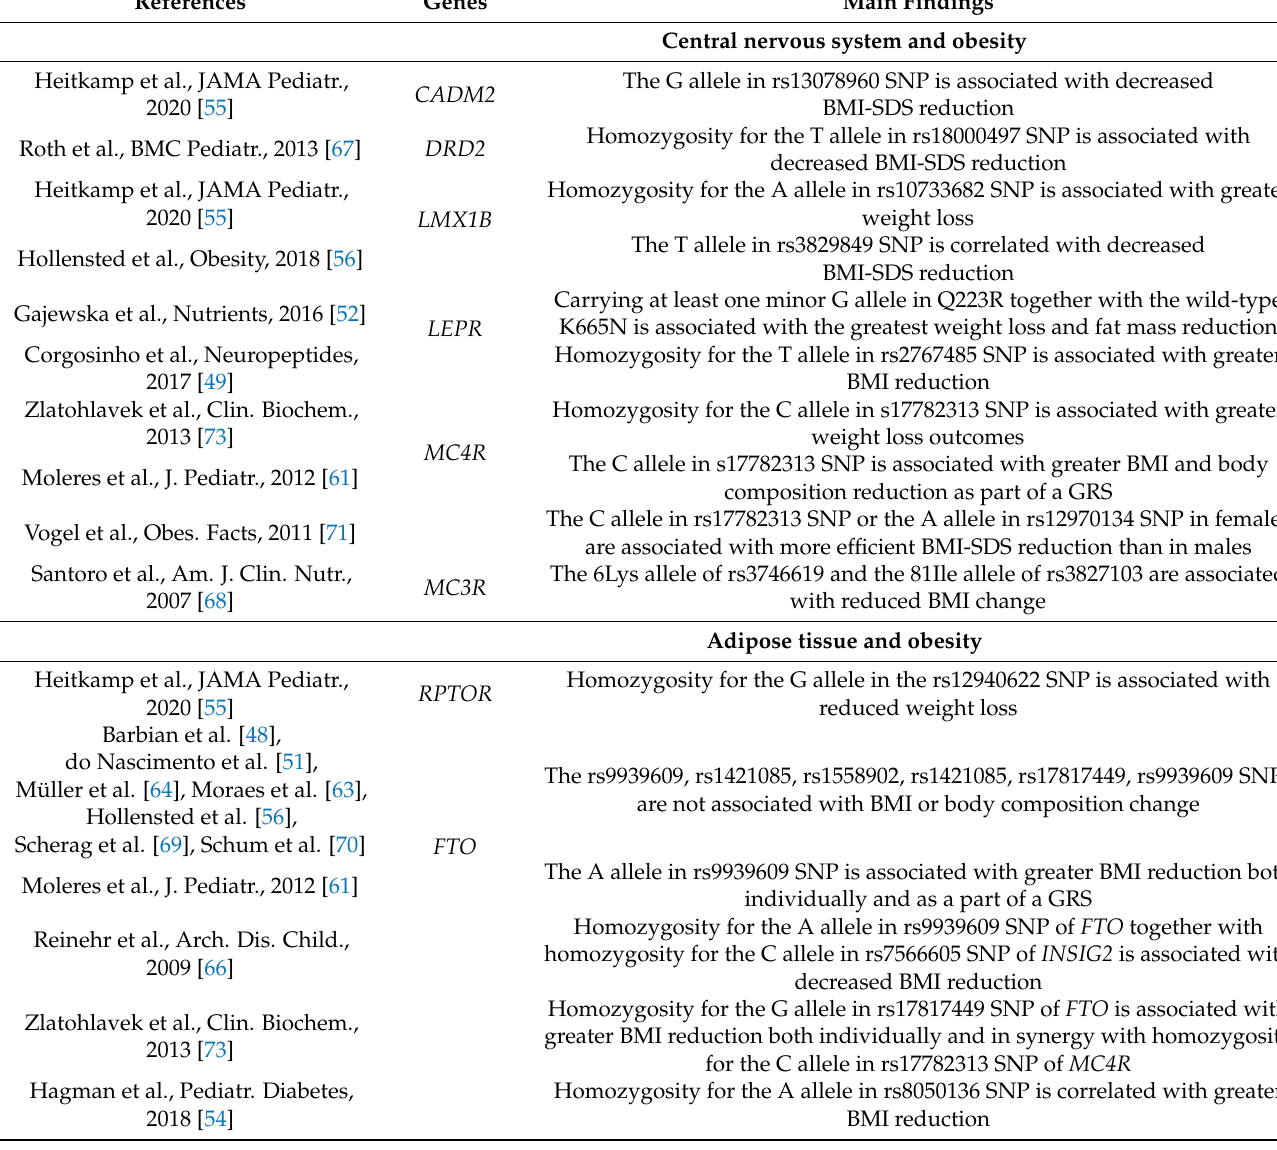
Table 4. Summary of the main associations identified between SNPs and BMI and/or body com- position change after multidisciplinary lifestyle interventions in children and adolescents with excess